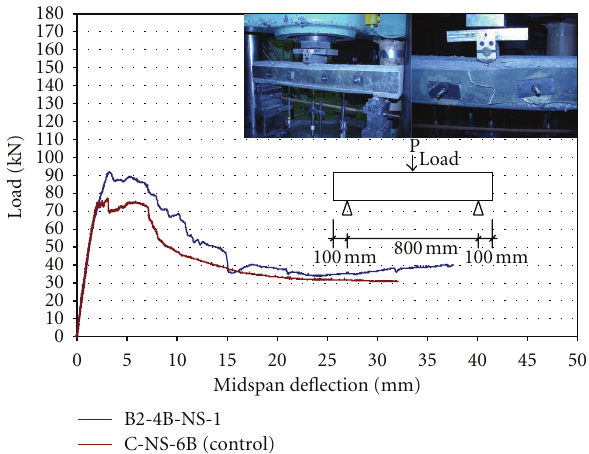
Figure 26: Load versus midspan deflection of RC beam B2-4B-S-1.